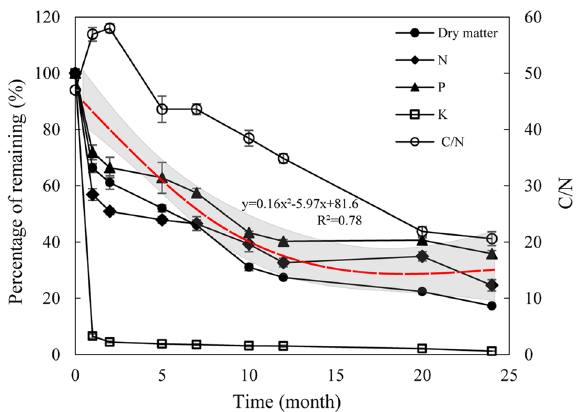
Figure 1. Dynamics of dry matter, N, P, K and C/N in straw